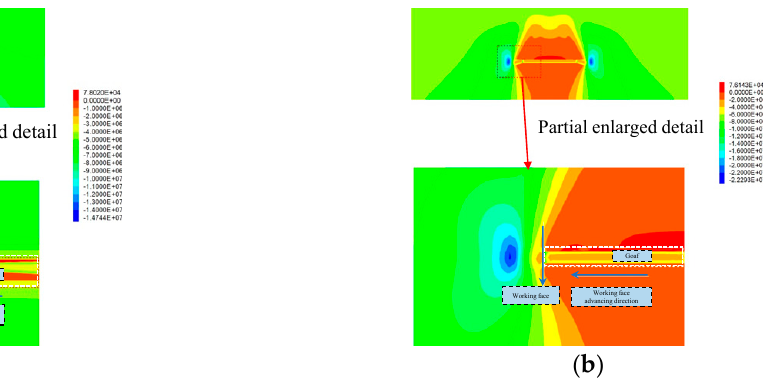
Figure 8. Local stress nephogram before grouting. ( a ) End section; ( b ) Middle section.